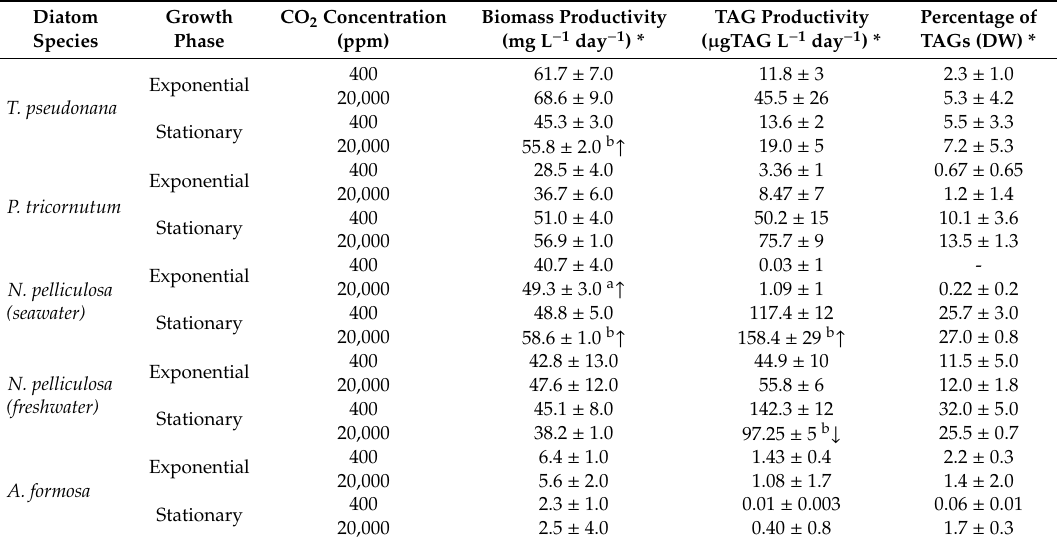
* All data is shown as average (n = 3) ± SD. a Significant difference between high and low CO 2 in in diatoms at stationary phase for a given species. ↑ and ↓ indicate increase or decrease, respectively. DW: Dry weight.